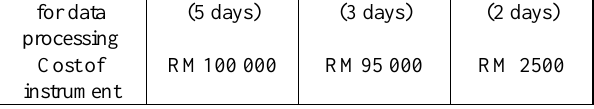
Table 4. General comparison between different